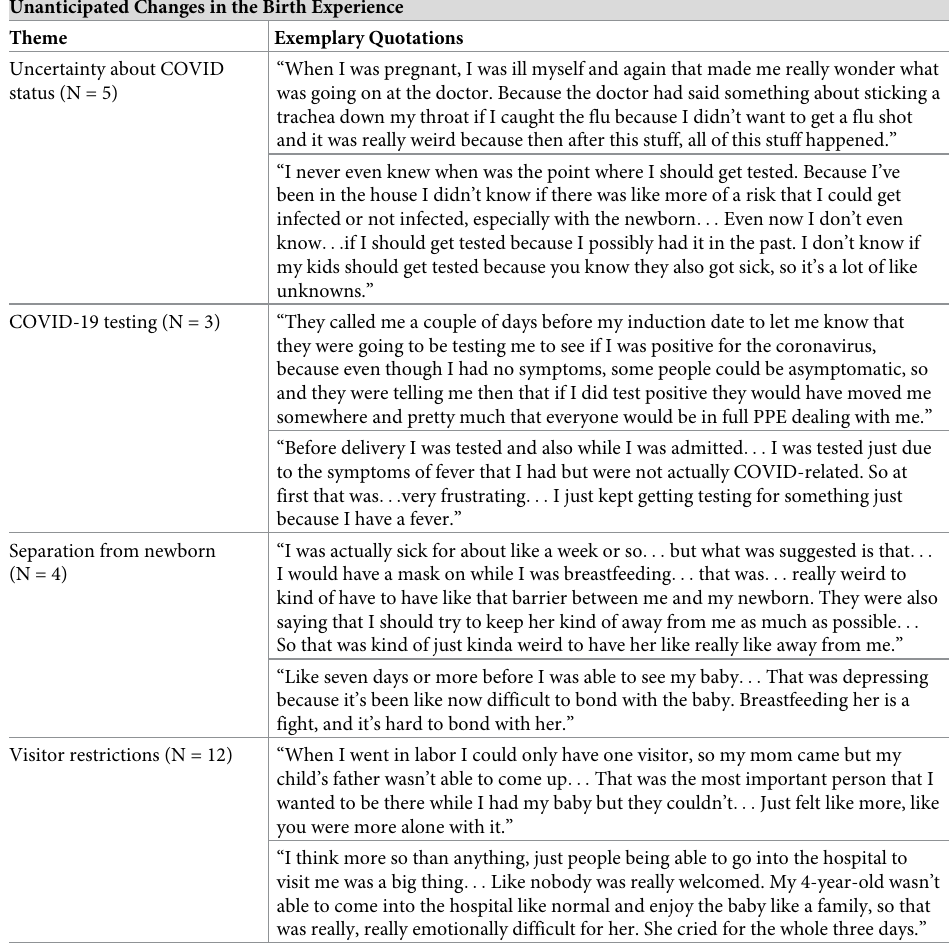
Table 3. Perceptions of postpartum participants on alterations to their birth